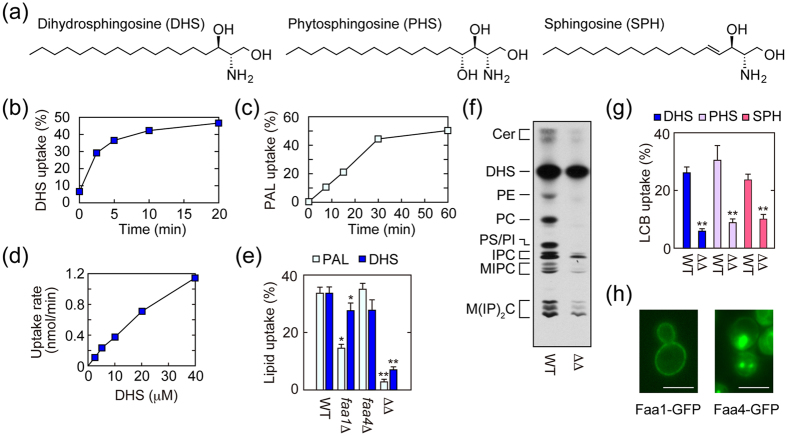
Faa1 and Faa4 are involved in the import of LCBs.(a) Structures of DHS, SPH, and PHS. (b–e,g) BY4741 (wild-type; WT) cells were incubated with [3H]DHS [(b), 20 μM; (d), indicated concentration] or [3H]palmitic acid (PAL) [(c), 20 μM] for the indicated time period (b,c) or for 5 min (d). BY4741, 6477 (faa1Δ), 833 (faa4Δ), and AOY13 (faa1Δ faa4Δ; ΔΔ) cells were labeled with 20 μM [3H]palmitic acid for 30 min or 20 μM [3H]DHS for 5 min (e). BY4741 and AOY13 cells were labeled with 20 μM [3H]DHS, [3H]SPH, or [3H]PHS for 5 min (g). Radioactivities associated with cells, medium, and glass test tubes were counted by a liquid scintillation counter, and those associated with cells are expressed as a percentage of the total radioactivity. Values represent the means ± SDs of three independent experiments, and statistically significant differences are indicated (t-test; *p < 0.05; **p < 0.01) (e,g). (f) BY4741 and AOY13 cells were labeled with 0.2 μCi [3H]DHS for 60 min. Lipids were extracted, separated by TLC, and detected by autoradiography. Cer, ceramide; PE, phosphatidylethanolamine; PC, phosphatidylcholine; PS, phosphatidylserine; PI, phosphatidylinositol; IPC, inositol phosphorylceramide; MIPC, mannosylinositol phosphorylceramide; M(IP)2C, mannosyldiinositol phosphorylceramide. (h) TNY42 (FAA1-GFP) and TNY51 (FAA4-GFP) cells were subjected to fluorescence microscopic observation using a DM5000B microscope (Leica Microsystems, Wetzlar, Germany). Bar, 4 μm.